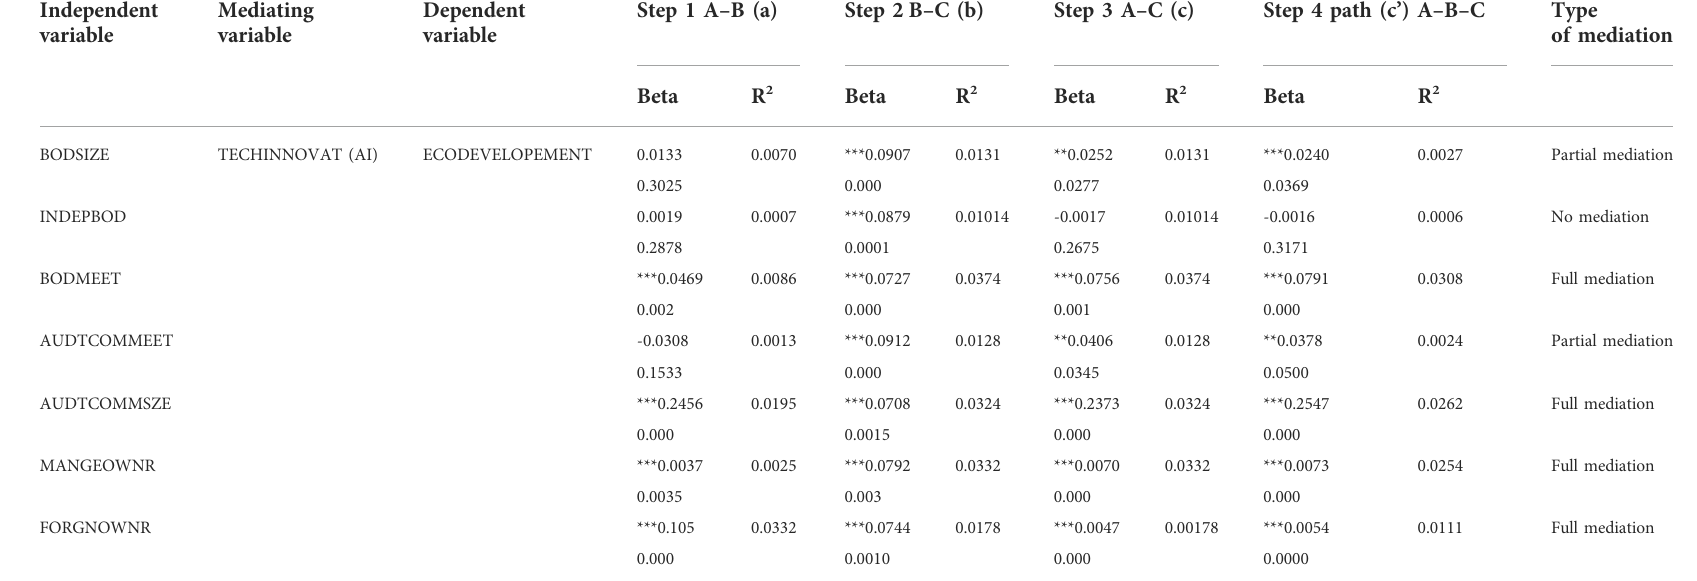
TABLE 6 CG, FFP, and